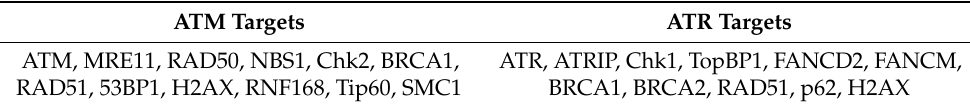
Table 1. DNA damage repair factors altered by HPV oncoproteins ATM and ATR DNA damage repair factors that are activated or increased in levels through the action of E6 and E7 oncoproteins. ATM Targets ATR Targets ATM, MRE11, RAD50, NBS1, Chk2, BRCA1, ATR, ATRIP, Chk1, TopBP1, FANCD2, FANCM, RAD51, 53BP1, H2AX, RNF168, Tip60, SMC1 BRCA1, BRCA2, RAD51, p62,